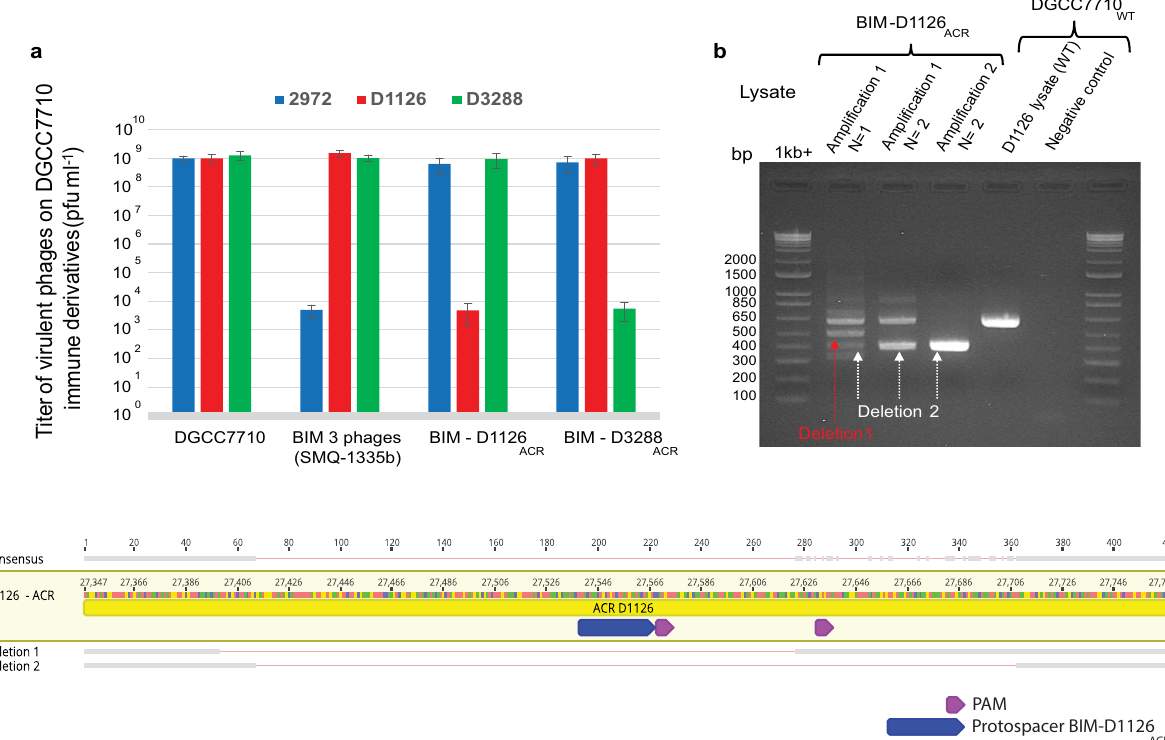
Fig. 1 A spacer that targets the acr gene provides phage resistance and leads to selection of phage-escaping mutants (CEM) containing a deleted acr gene. a Titers of phages carrying no ACR (phage 2972 in blue) or AcrIIA5 (D1126 in red) or AcrIIA6 (D3288 in green), on four S. thermophilus strains, namely the phage-sensitive strain DGCC7710, strain SMQ-1335-b containing a spacer in its CR1 array perfectly matching a conserved region in the three phage genomes, strain BIM-D1126 ACR containing a spacer matching the acrIIA5 gene of phage D1126, and strain BIM-D3288 ACR containing a spacer matching the acrIIA6 gene of phage D3288. The BIMs carrying a spacer targeting an acr gene provided a signi fi cant phage resistance phenotype (lower phage titers). The titers are from three biological replicates and each of two technical replicates. Error bars represent standard deviation. b PCR analyses on phage lysates based on the ampli fi cation of phage D1126 infecting the BIM that targets its acr (BIM-D1126 ACR ). The acr gene was ampli fi ed by PCR after two rounds of phage ampli fi cation. The gel shows deleted (lanes 2 – 4) and full-length (lane 5) PCR products for the acr in the CEM and wild-type phage D1126, respectively. c Nucleotide sequence alignment of the deleted and wild-type acr genes (PCR products) shows deletions within the targeted protospacer